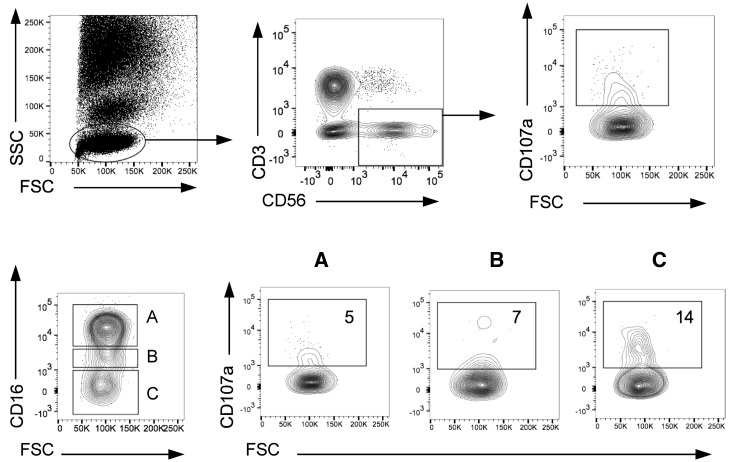
NK cell degranulation assay: relationship between NK cell expression of CD107a and CD16Flow cytometry-gating strategy to assess NK cell degranulation. Whole blood samples were incubated with or without mAbs for 24 h before analysing by flow cytometry. NK cells were identified based on forward- and side-scatter characteristics and CD56+CD3−. The frequency of CD3−CD56+CD107a+ cells represented activated/degranulated NK cells. The relative frequency of activated CD107a+ NK cells based on CD16 expression in three subpopulations of CD3−CD56+ NK cells was identified based on the relative expression of CD16 (boxed as A, B and C above). FSC: forward-scatter; SSC: side-scatter.